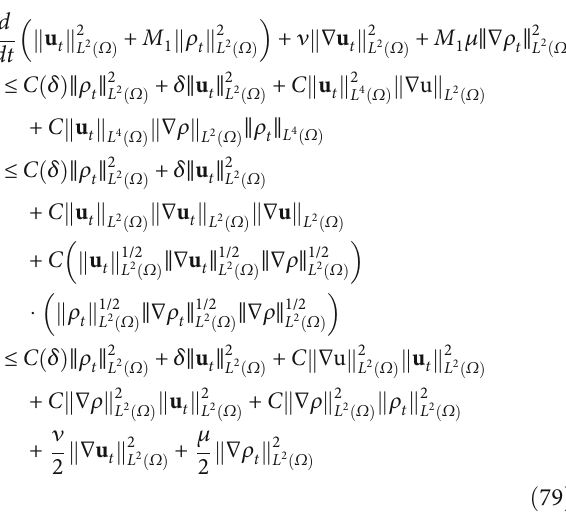
ffiffiffiffiffiffiffiffiffiffiffiffiffiffiffiffiffiffiffiffiffiffiffiffi min